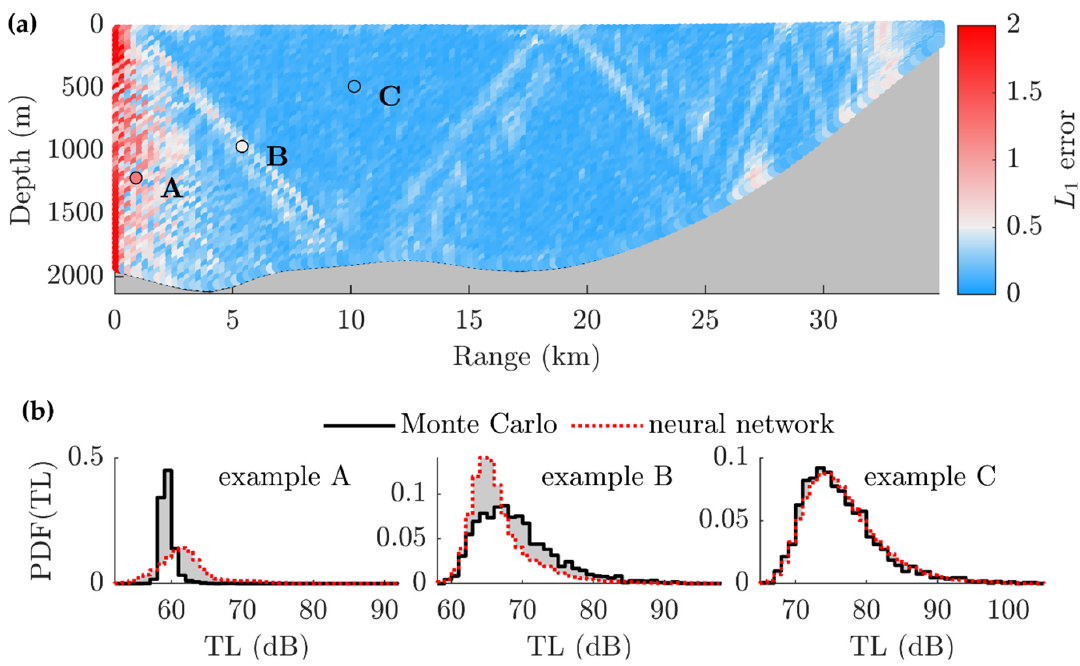
Figure 7. Final histogram NN performance for a sample test case. ( a ) The L 1 errors of the final histogram NN’s predictions on the examples in case 101 (a testing case) at each example’s receiver location. Results from the three labeled receiver locations are shown in ( b ). The NN’s predicted PDF of TL (dashed red line) is compared to the MC PDF of TL (solid black line) at three receiver locations and the L 1 error is visualized as the shaded area for each. The L 1 errors for examples A, B, and C are 1.246, 0.507, and 0.117